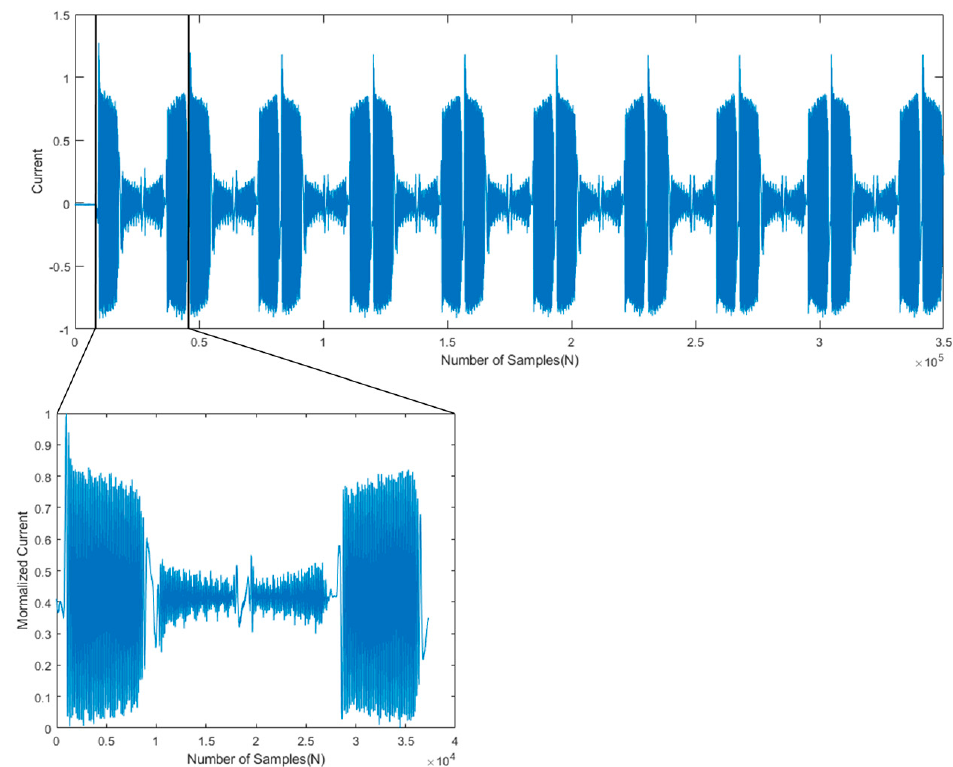
Figure 2. Signal segmentation into each cycle from the original data. Table 1. Extracted features in different domains.